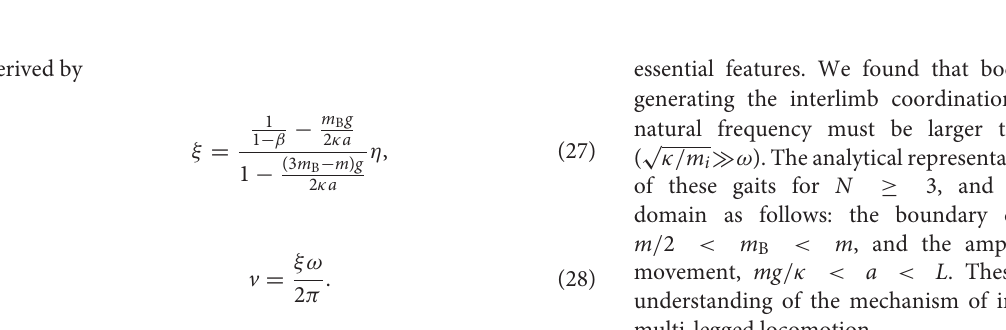
- ˆ ψ i i - ˆ ψ i i space; (B) direct- and source-wave gaits − 1 + 1 3,4) projected onto the ˆ ψ 2 1 - ˆ ψ 2 2 - ˆ ψ 2 3 =